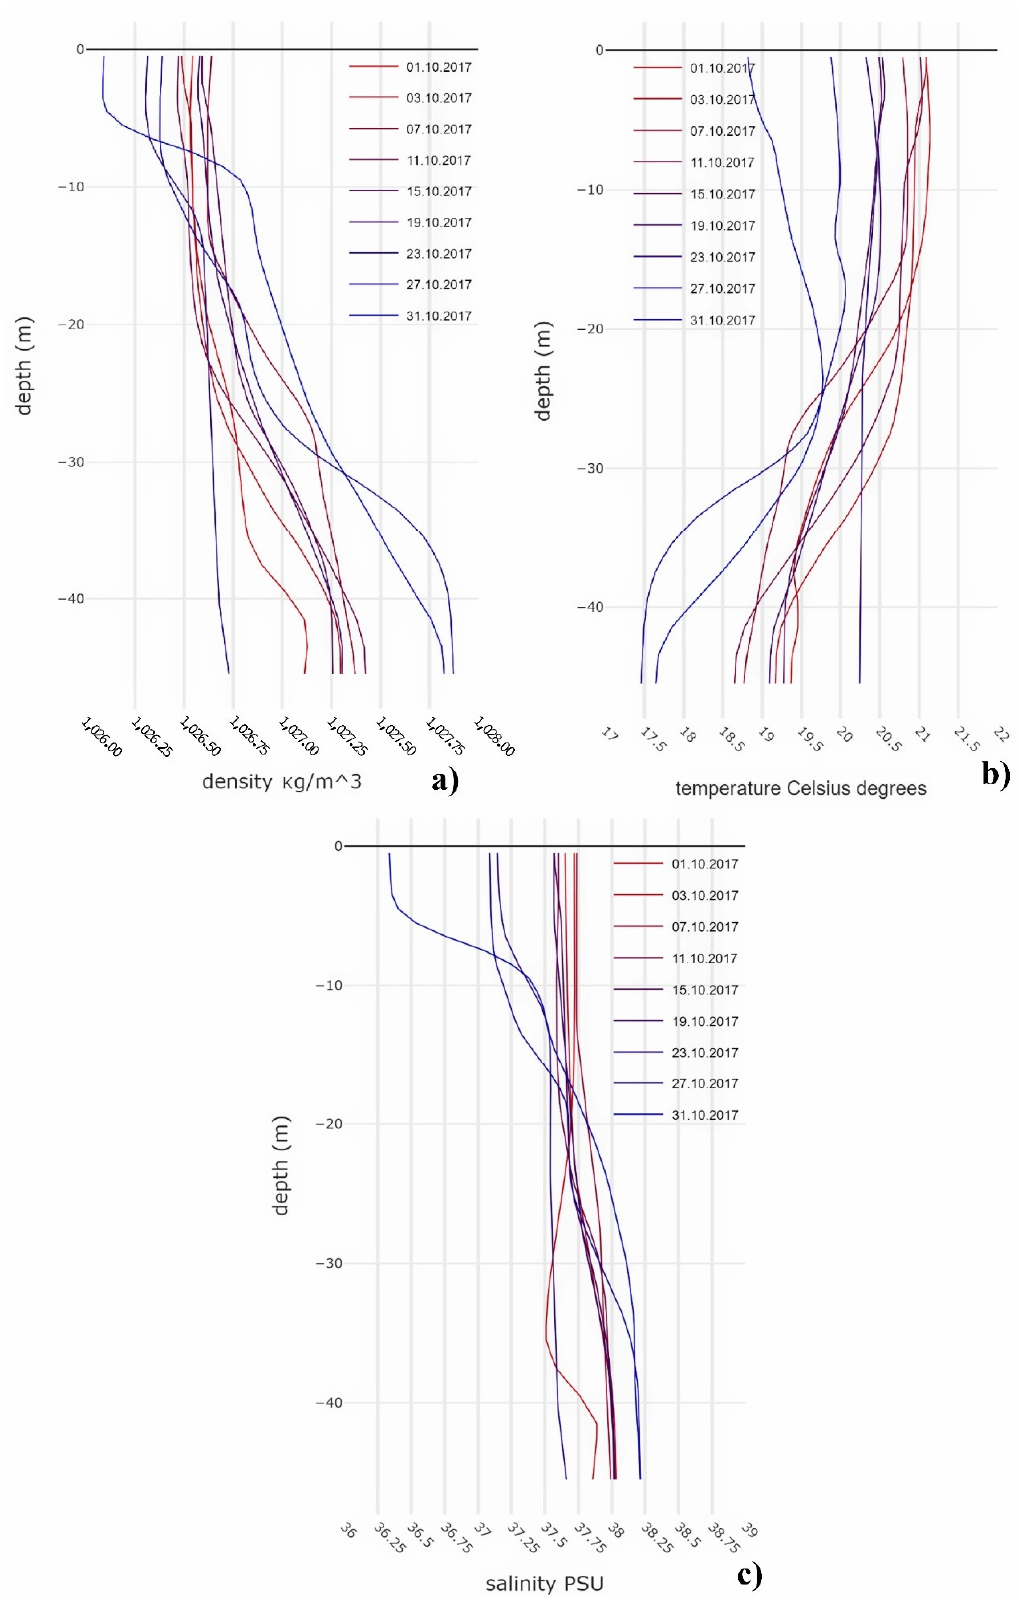
Figure 6. ( a ) Salinity, ( b ) temperature, and ( c ) density profiles computed by MIKE 3 HD for the simulation period 1–31 October 2017, for Plt A site.